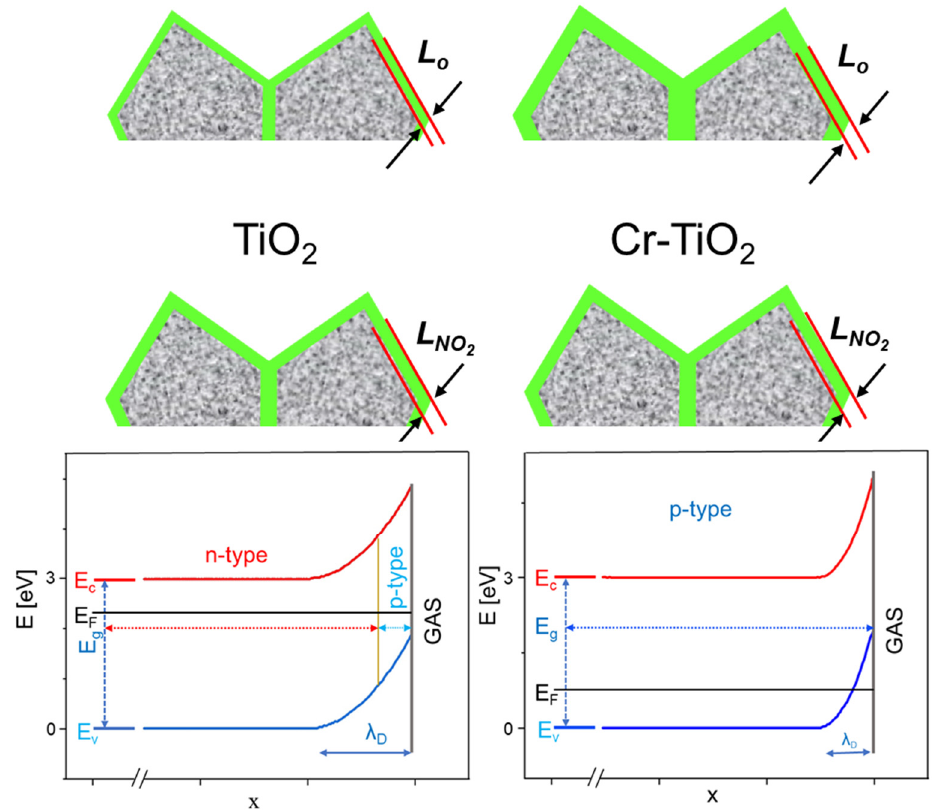
Figure 10. The sensing mechanism of NO 2 adsorption onto pristine (n-type) and Cr-doped TiO 2 (p- type) sensing layers. (p-type) sensing